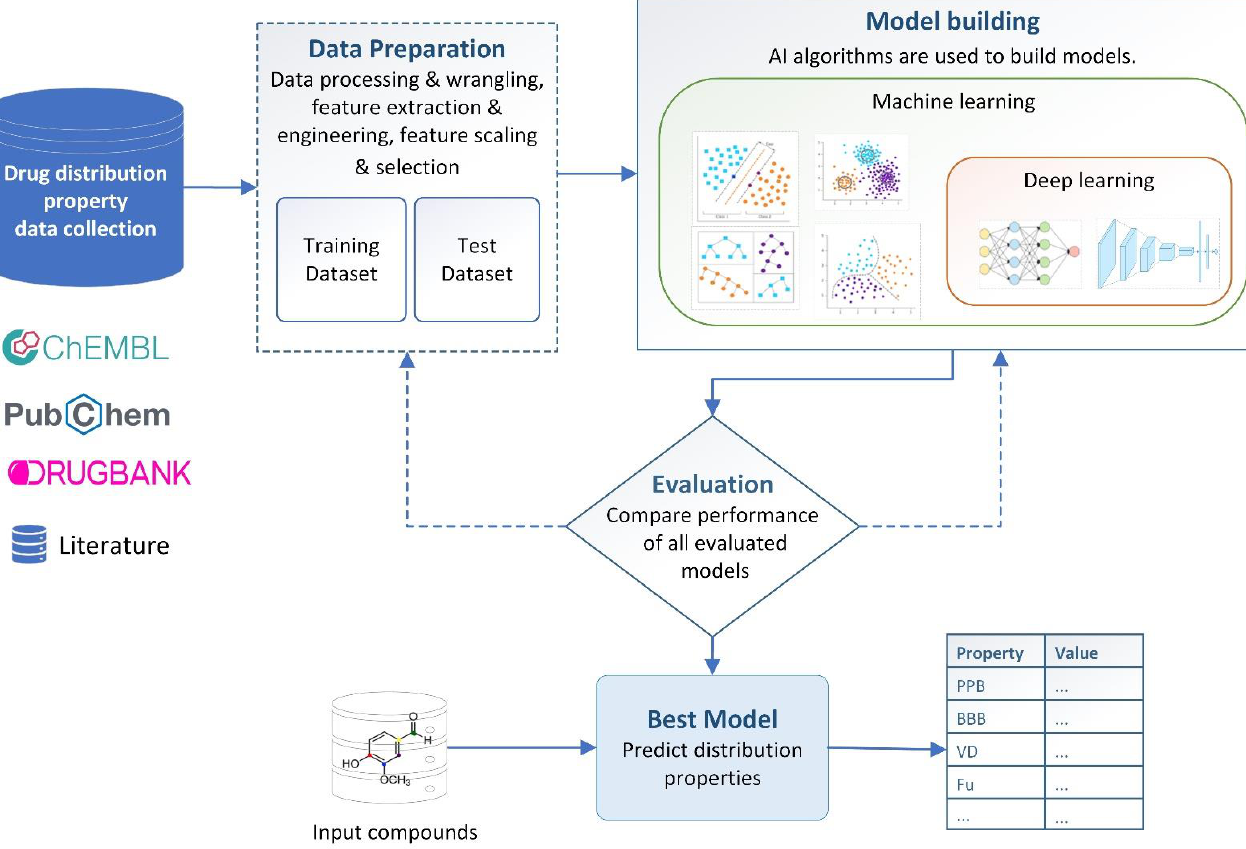
Figure 3. General structure of a drug distribution property prediction model using AI.